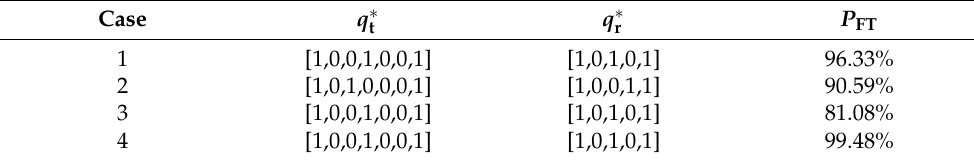
Figure 4. The different layouts for the subset selection algorithm of predetermined size: ( a ) Case 1, ( b ) Case 2, ( c ) Case 3, ( d ) Case 4. Table 2. Simulation for subset selection strategy of predetermined